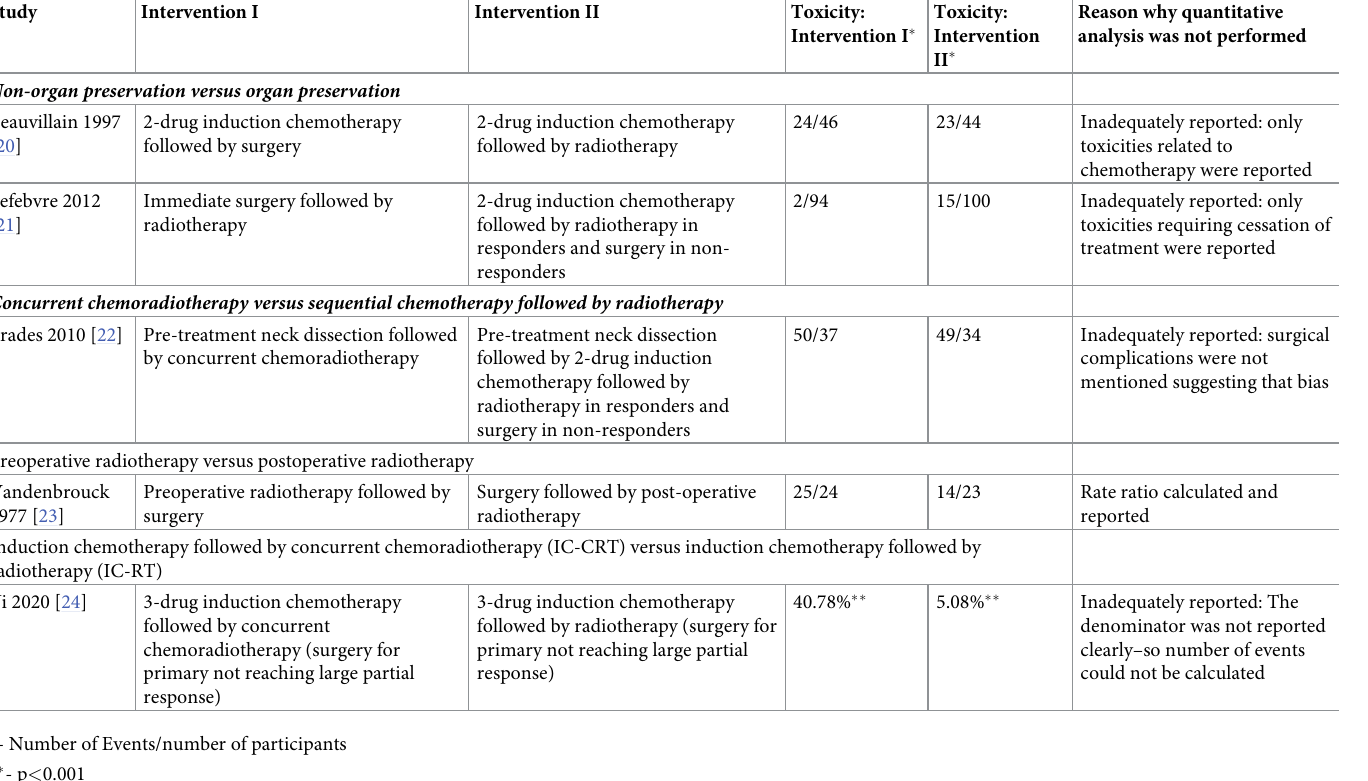
Table 2. Summary of treatment-related